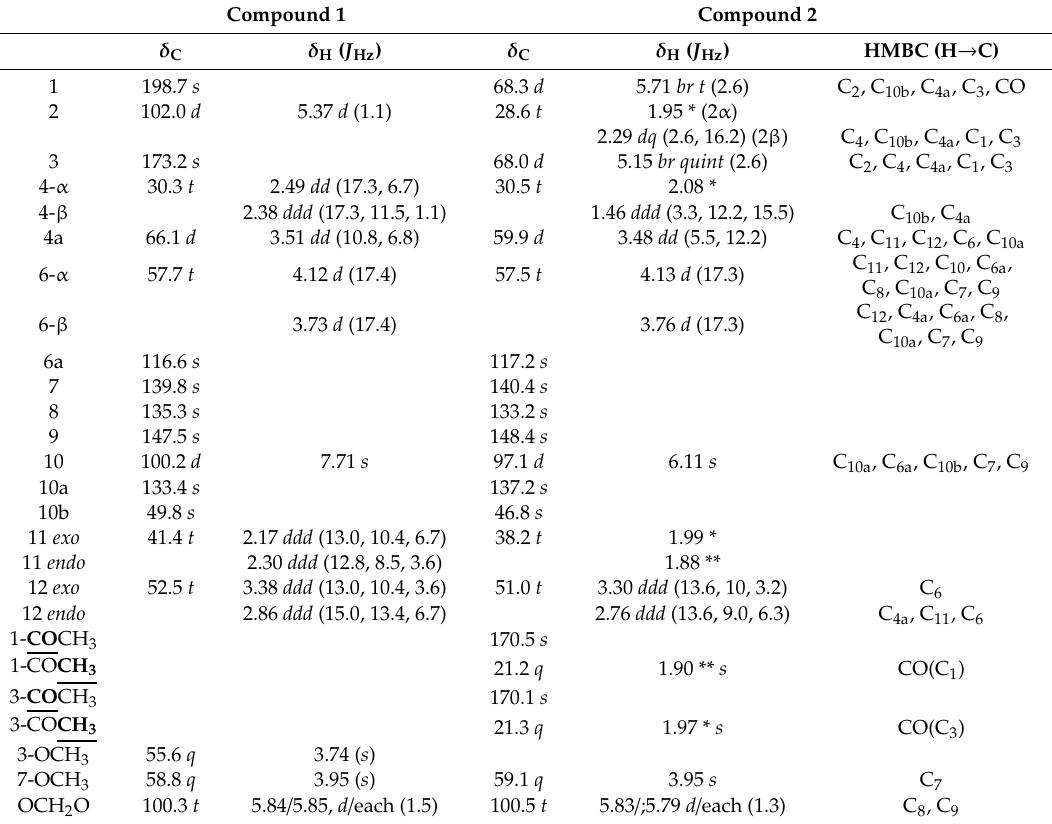
Table 1. 1 H (400 MHz) and 13 C-NMR (100 MHz) data for compounds 1 and 2 in CDCl 3.